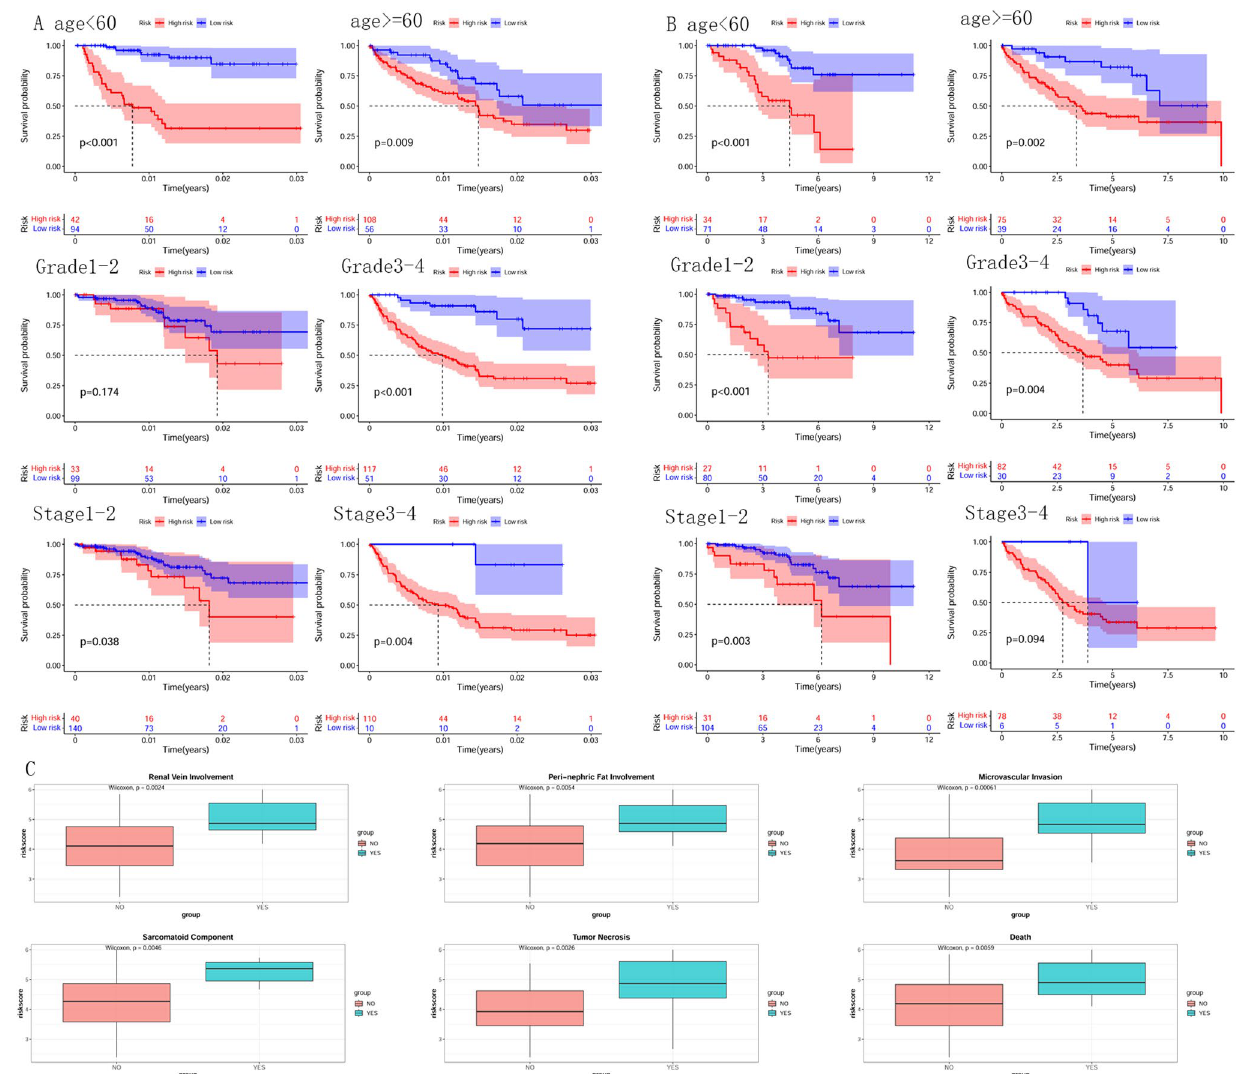
the high-risk group, and blue indicates the low-risk group. ( A ) TCGA training set group validation. ( B ) TCGA test set group validation ( C ) GSE29609 test set group validation. Risk scoring was significantly different in subgroups such as renal vein involvement, peri-nephric fat involvement, and microvascular